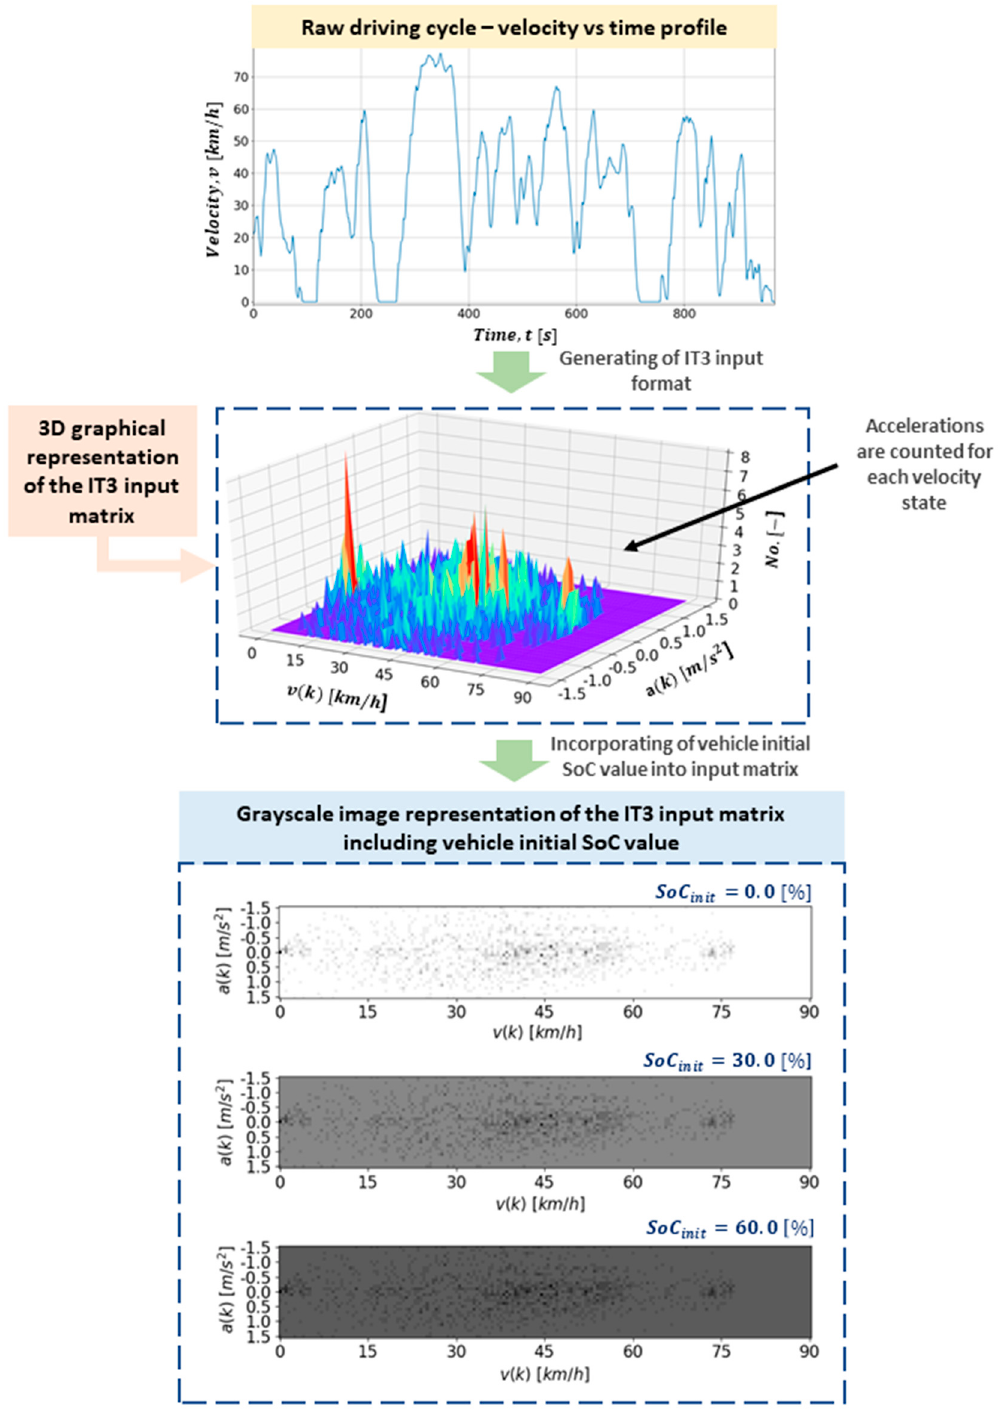
Figure 3. Illustration of process of generating NN input type IT3.